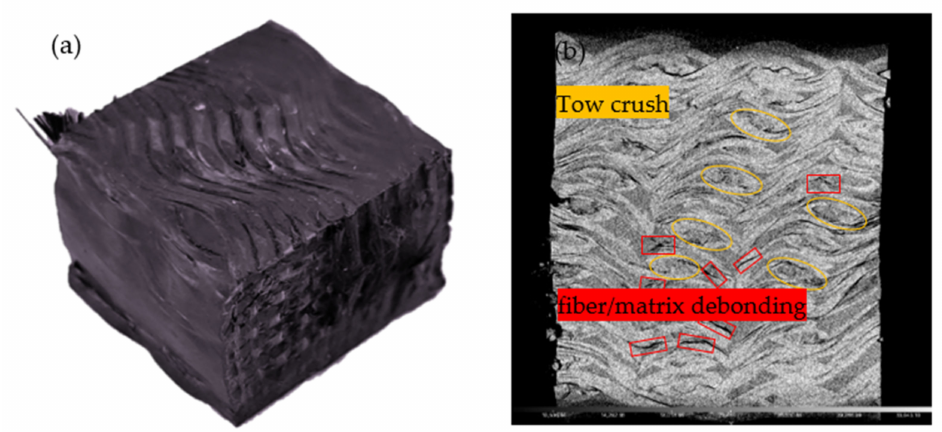
Figure 6. Damage pattern of quasi-static compression test in the weft direction: ( a ) macroscopic damage images; ( b ) internal microscopic